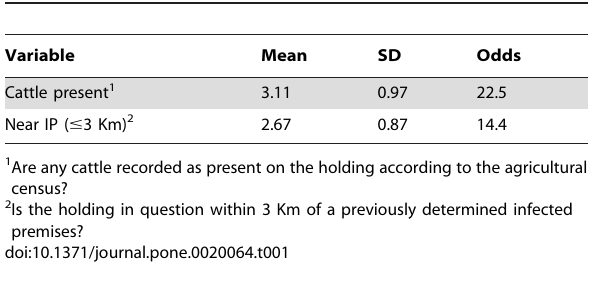
Table 1. Results from Bayesian discovery model - mean and SD of coefficients of logistic model (and odds ratio) predicting discovery of an infected